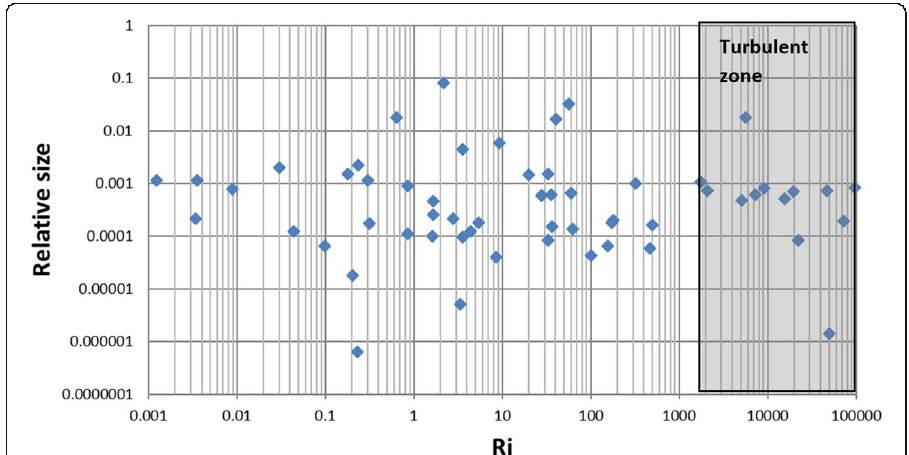
Fig. 8 Relative size versus R i number for 2010 –